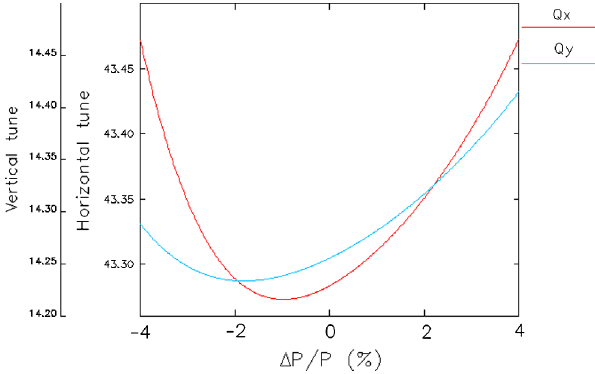
amplitudes.FIG. 5. Shift of transverse tune due to (cid:3) 4% energy errors.